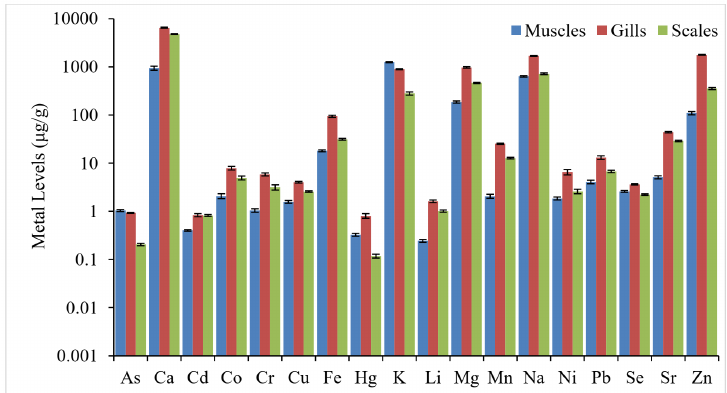
Figure 2. Comparison of average metal levels ( µ g/g ± SE) in the muscles, gills and scales of Catla catla .